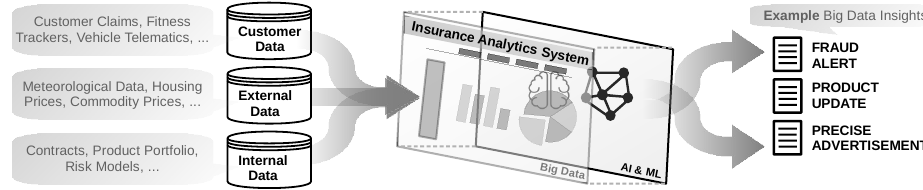
Figure 2. Information flow, for example, insurance use cases of big data